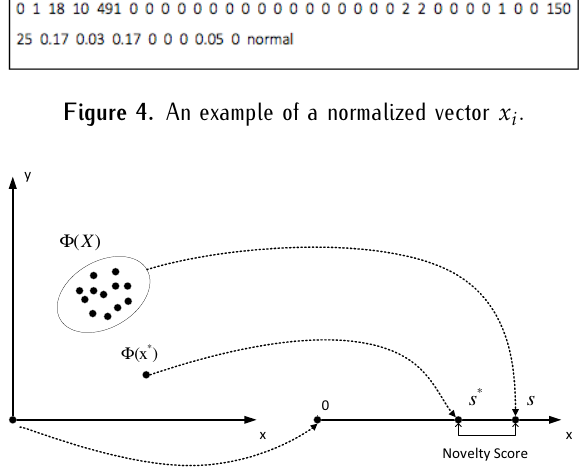
Figure 5. The samples are separated from the origin in the kernel feature space with a mapping Φ , then mapped on a point s , and the novelty score of a testing sample x ∗ is the distance of its projection s ∗ to s